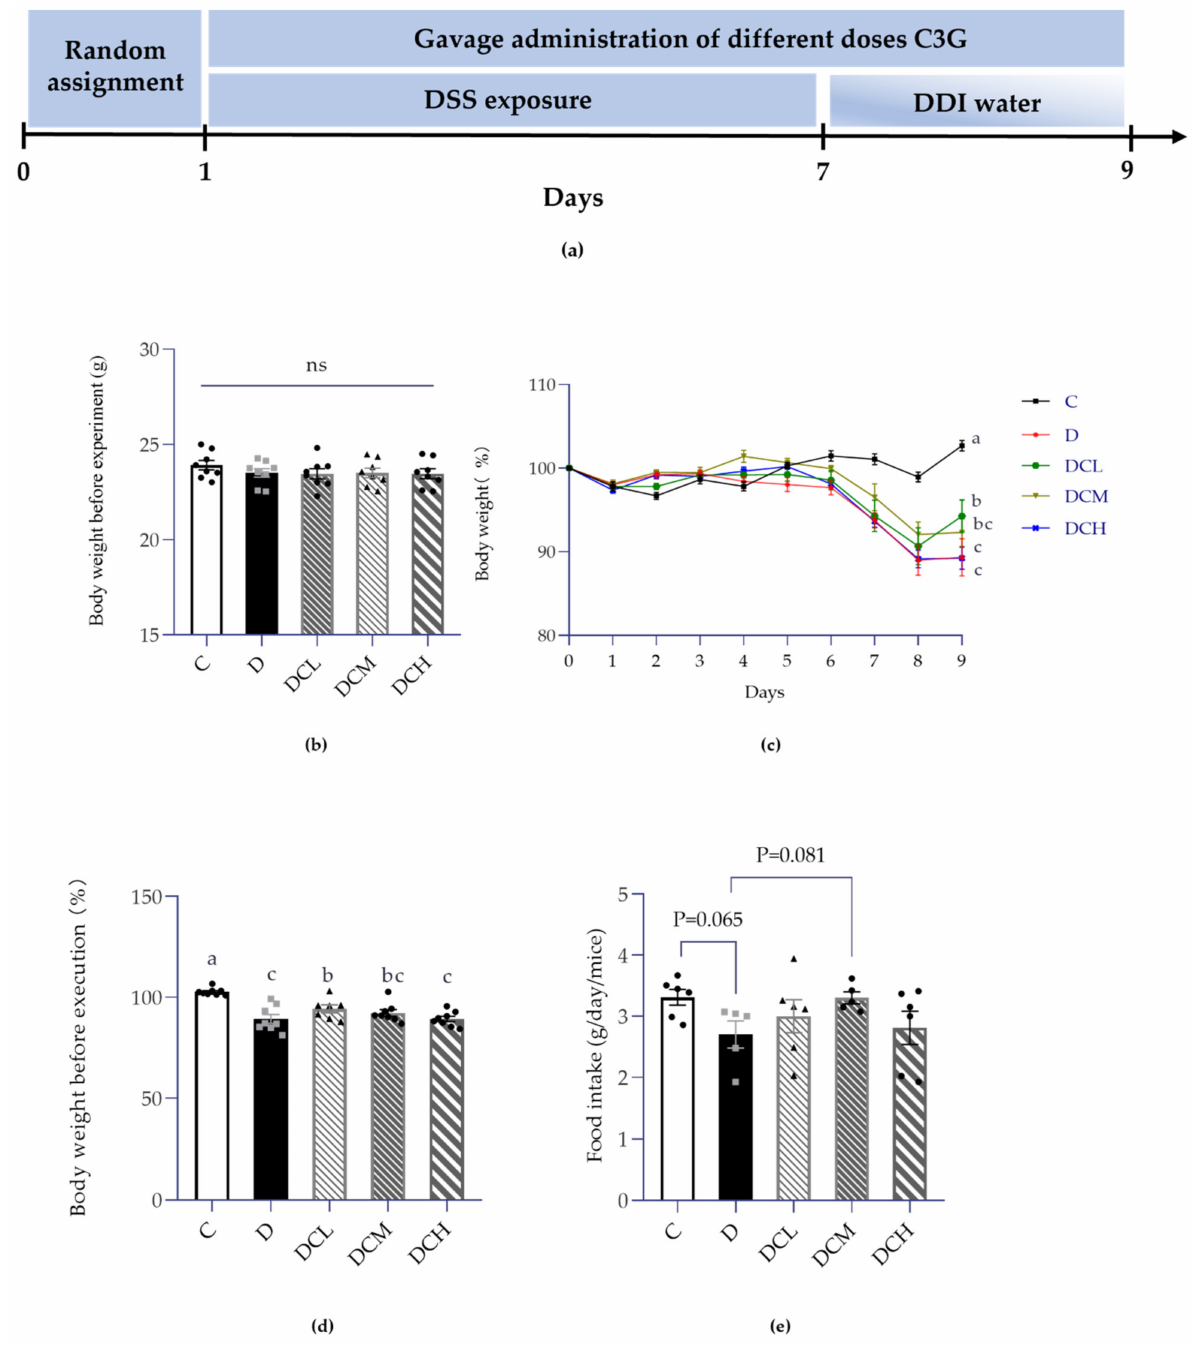
Figure 1. Effects of DSS on weight gain and food intake of mice (ns, non-significant; Control, C; DSS-treated mice, D; DSS-C3G (12.5 mg/kg), DCL; DSS-C3G (25 mg/kg), DCM; DSS-C3G (50 mg/kg), DCH). ( a ) Experimental timeline of UC model. ( b ) The initial weight of mice on the 0th day of the experiment. n = 8. ( c ) Dynamic change of body weight (shown as percentage). n = 8. ( d ) Body weight before execution (%). n = 8. ( e ) Daily food intake per mouse (g). n = 5~6. (cid:78) • (cid:4) : The number of symbols was consistent with the number of samples, and the relative position represented the degree of data dispersion. Results were expressed as mean ± SEM. Parameters marked by the same letter are not significantly different. Significance is represented as p <